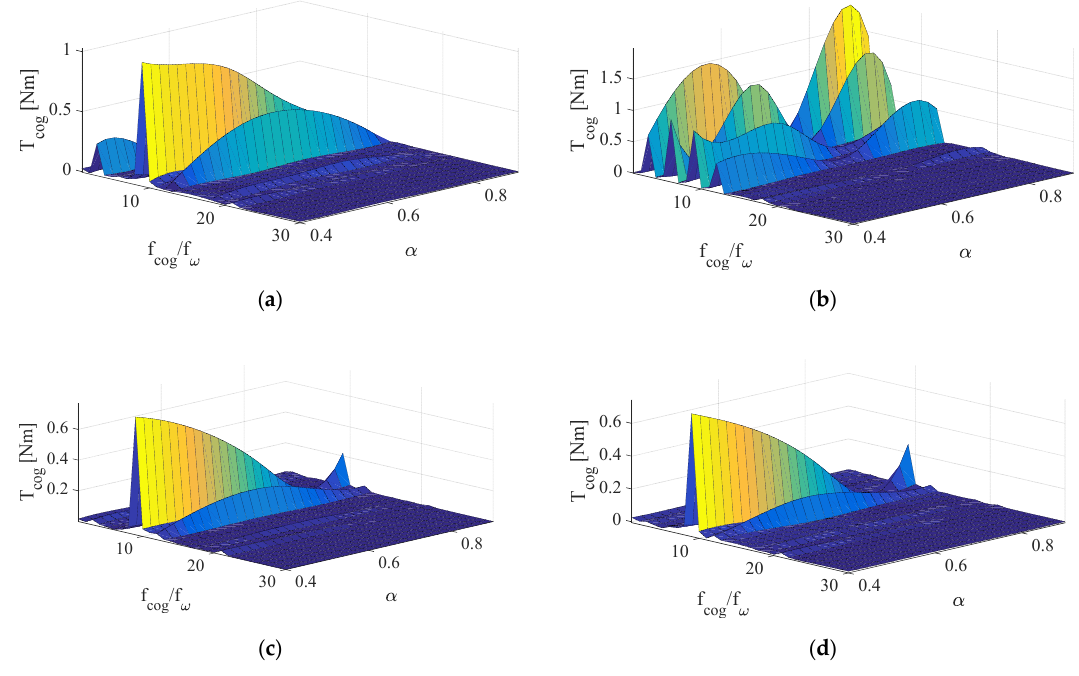
Figure 13. Cogging torque spectrum of 8 poles ( a ), 12 poles ( b ), 14 poles ( c ) and 16 poles ( d ) rotors.